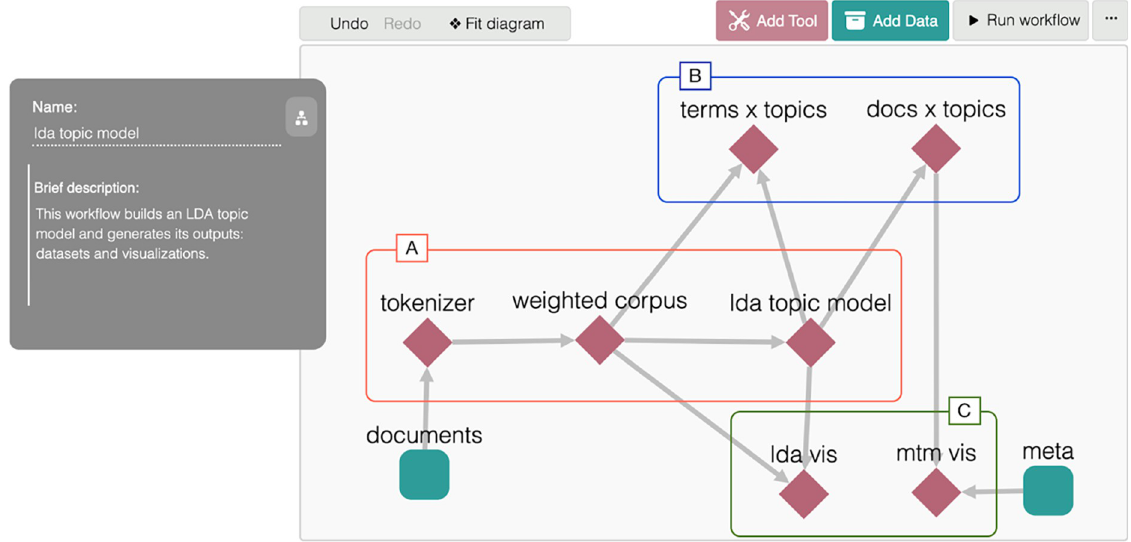
Fig 11. The MITAO workflow used for building a LDA topic model (i.e., rectangle A) and generating the datasets (rectangle B), and the visualizations (rectangle C). The workflow takes two inputs: the documents, and the metadata of the documents.